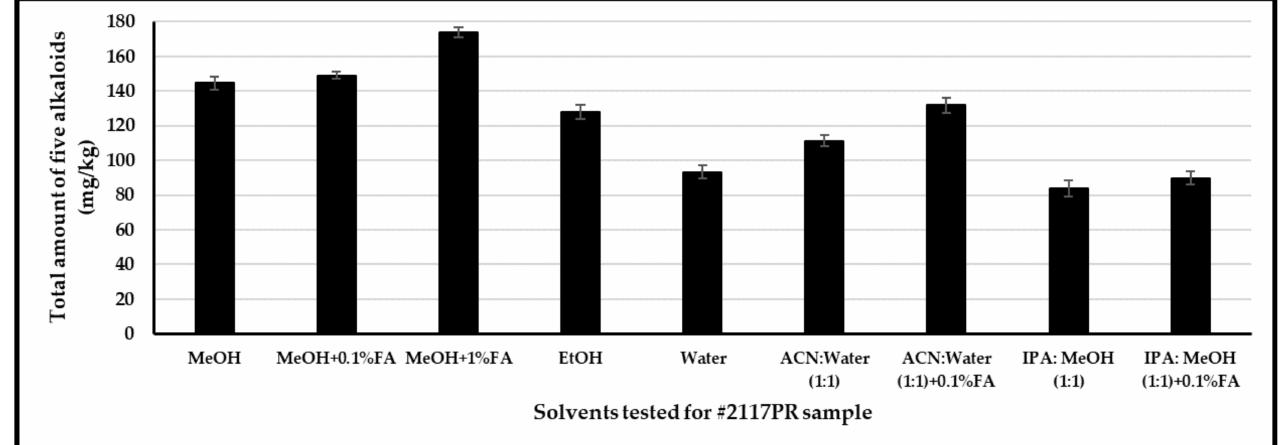
Figure 4. Extraction efficiency of opiates in 2117PR with various